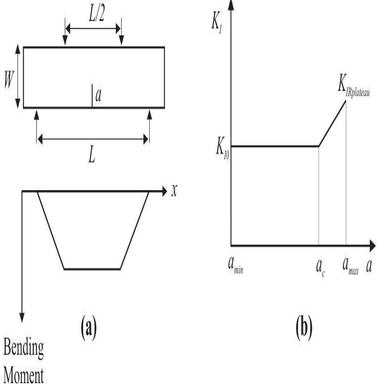
(a) 4-Point bending test specimen with surface crack (b) Change of fracture toughness with respect to crack length in simple sample model.